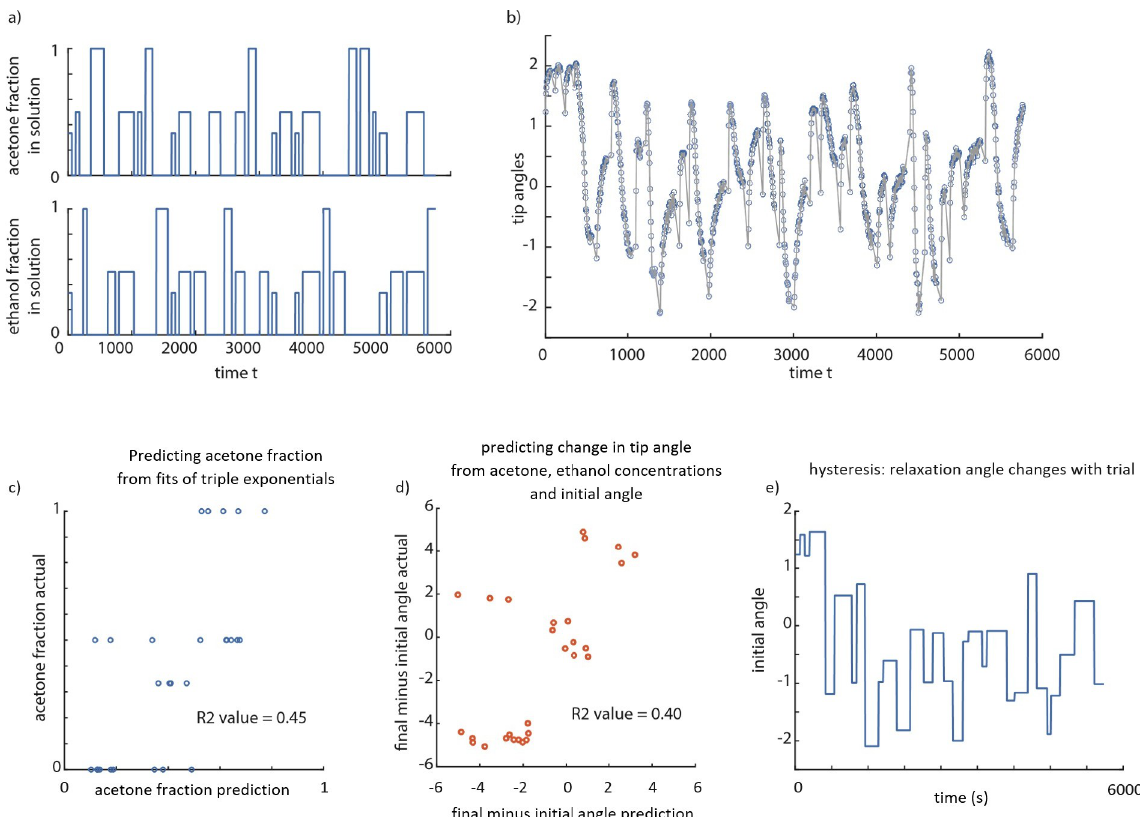
Fig 7. Predictions from filament bending and predictions of filament bending. (A) A sample series of 30 exposures to varying solution fractions of acetone, ethanol and water are shown. (B) The filament tip angles (relative to some absolute orientation) are shown as a time series. These correspond to the exposures in panel-a. (C) Predicting the acetone fraction in solution using a linear model based on fitting a triple exponential to transients gives about 0.45 R 2 value, suggesting some but not perfect predictive ability. (D) Predicting the change in tip angle over a trial using the acetone fraction, ethanol fraction, and the initial angle using a linear model gives about 0.4 R 2 value. (E) The initial angle for each trial–which was the angle to which the filament relaxed after the previous trial–changes over time, suggesting hysteresis, or slower time- scale processes over many tens of